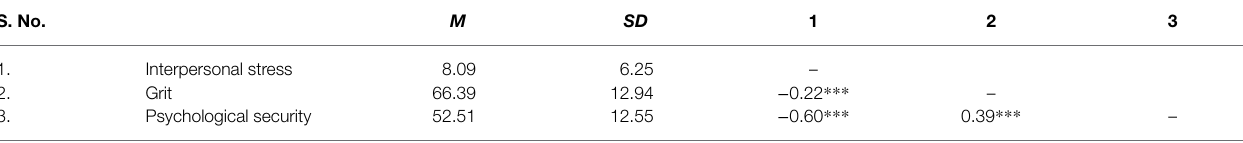
TABLE 3 | The mean ( M ), standard deviation ( SD ), and correlation coefficients of the main variables in Study 2. S. No.